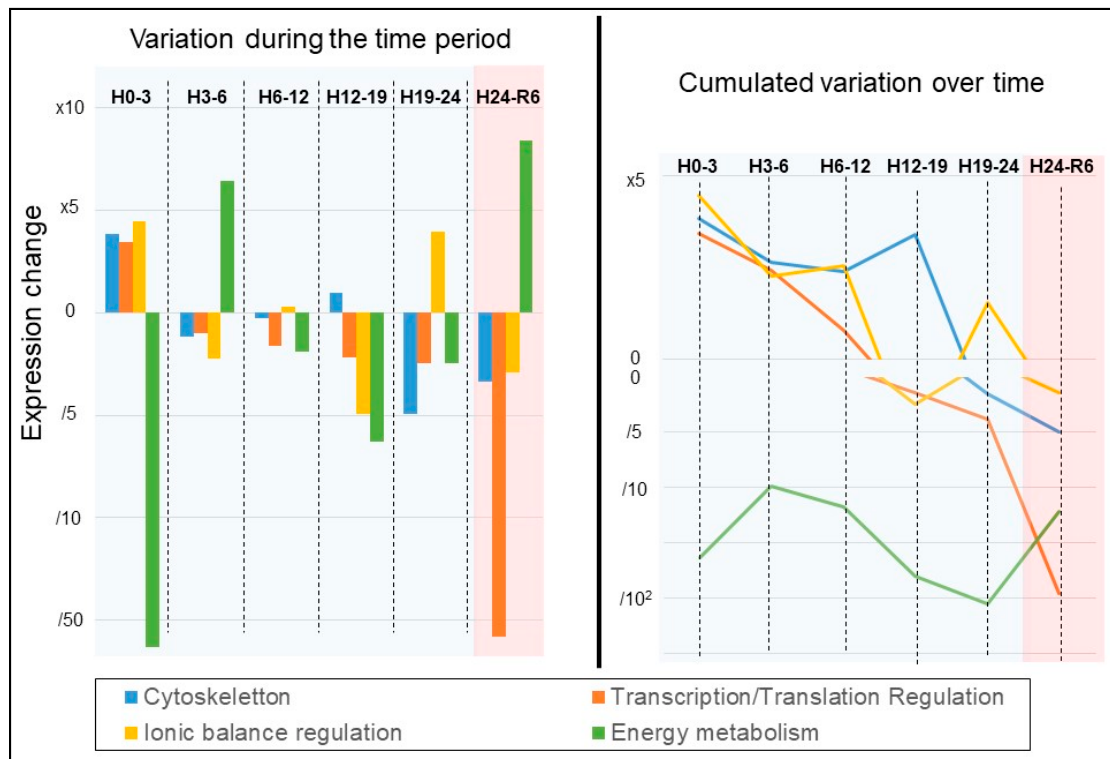
Figure 8. Kinetics of protein expression during the procedure, by ontology. We averaged the expression change for the proteins belonging to the most represented ontologies: Cytoskeleton, Transcription/Translation Regulation, Ionic Balance Regulation, Energy metabolism. Left Panel: average change reported for each time period independently. Right Panel: cumulated change in expression over time. (N = 3, n = 3).